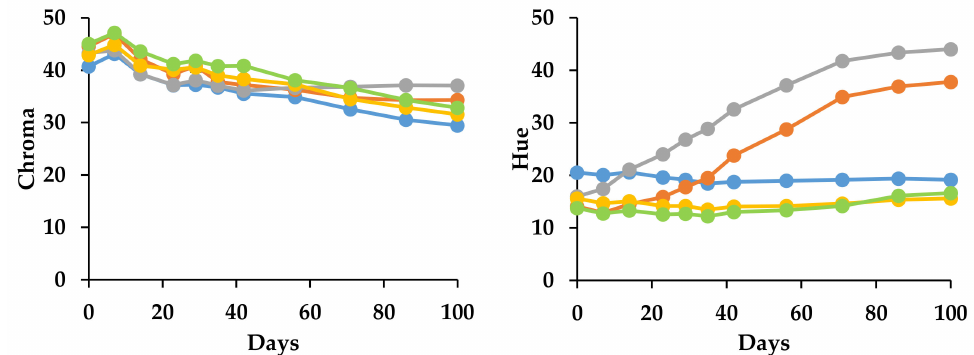
Figure 6. Effect of intermolecular copigmentation on total color difference, L *, a *, b *, chroma, and hue angle during storage at 20 ◦ C in pH 3.0 buffer solutions. *Anthocyanins (ATC); L * (lightness); a * (redness/greenness); b * (yellowness/blueness).